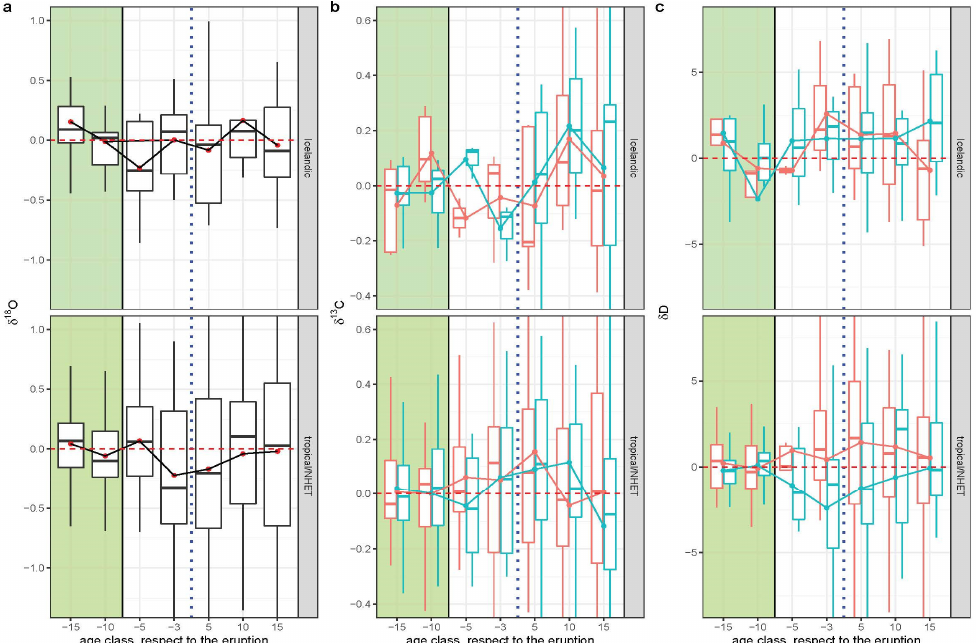
Figure 8. Analysis of the main volcanic eruptions after 0 CE: Boxplots of the cellulose isotope anomaly ( δ 18 O ( a ); δ 13 C ( b ); δ D ( c )) for the 34 strongest volcanic eruptions after 0 CE included in [2]. The cellulose isotope values are from the Eastern Alpine Conifer Chronology database and have a 5-year resolution. The Northern Hemisphere Extra Tropical (NHET) and tropical eruptions are separated from the Icelandic ones; the larch trees and the cembran pine are represented as red and blue boxes, respectively. The data are aligned on the year of the eruption, indicated by the blue dotted vertical line. Forcing and response are calculated to a 10-year background period before the eruption, with the assumption that it is undisturbed by volcanic eruptions. The solid lines connect the mean value of each boxplot. The calibration period is shaded in green, and the horizontal red dotted line is the average of the calibration period. The points are the mean values of each boxplot.